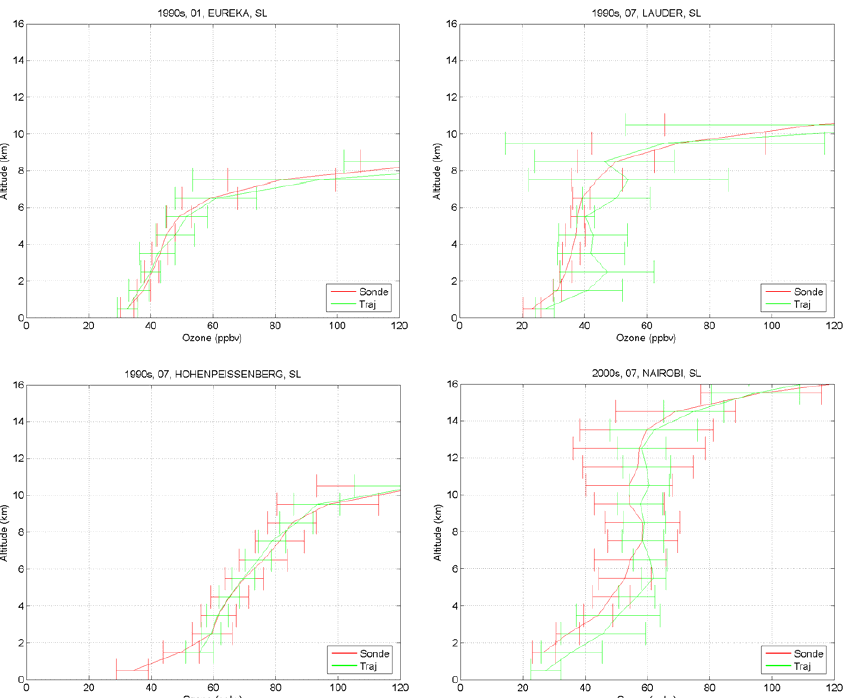
Figure 4: Comparisons between the monthly (01=January; 07=July) averaged measured ozonesonde profiles and trajectory-mapped fields, for several sites. “Sonde” is the ensemble of measured profiles for that site; “Traj” is the profile generated from the mapping procedure when data from that site is omitted. Error bars indicate 2- σ confidence levels. The vertical coordinate is altitude from sea level (SL).